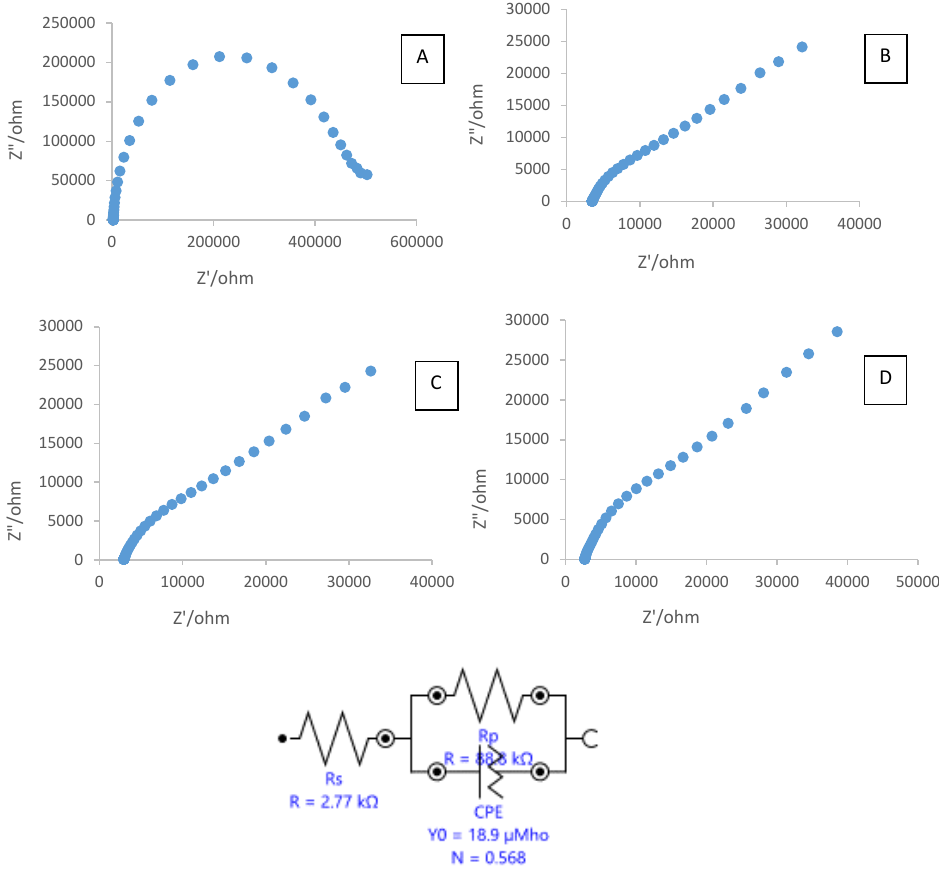
Figure 5. Electrochemical impedance spectroscopy (EIS) of: ( A ) bare SPCE; ( B ) SPCE/CTAB; SPCE/CTAB/PEG; ( C ) and SPCE/CTAB/PEG-ZrO 2 ( D ) in 5.0 mM K 4 Fe(CN) 6 containing 0.1 M KCl as a supporting electrolyte.